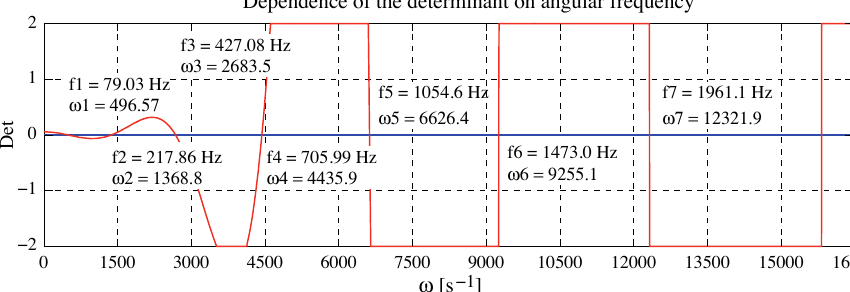
Fig. 6. Natural frequencies of fixed-fixed beam.